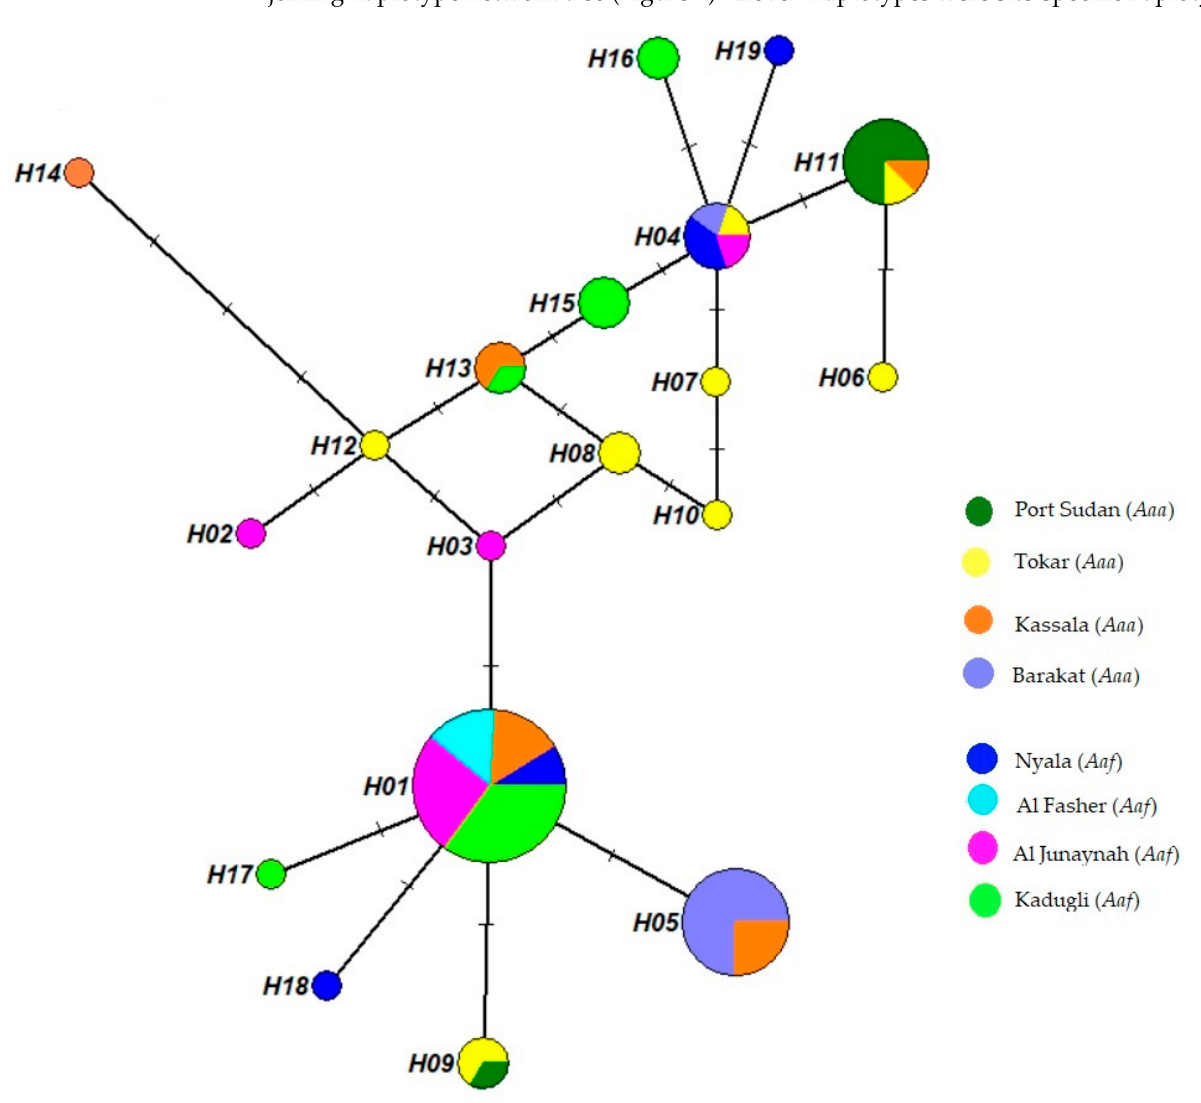
Figure 2. Aedes aegypti haplotype network tree with median-joining haplotypes. The tree was built using 19 haplotype ND4 sequences from 8 study sites. Each circle’s size represents the frequency of the haplotype’s occurrence. A minimum of 1 mutation exists between 2 haplotypes. Hap 1 showed higher frequency and included mosquitoes from all Aaf populations and the Kassala population of Aaa , followed by Hap 5, which was found in the and Kas- sala Aaa populations. Ten haplotypes appeared only in a single mosquito, while many mosquitoes shared nine haplotypes. Hap 1 was found in 73.6% of Aaf populations, while Hap 5 was observed in 29.3% of Aaa populations and appeared in only two populations (Kassala and Barakat), in addition to Hap 11, which appeared in Port Sudan, Tokar and Kassala and was found in 19.5% of all the Aaa samples. The Aaa and Aaf populations shared three haplotypes (Figure 2). Hap 1 was detected in 39 Aaf samples from Nyala, Al Fashir, Kadugli and Al Junaynah and appeared in 7 Aaa samples in Kassala. Hap 4 was found in three Aaf samples from Nyala and Al Junaynah